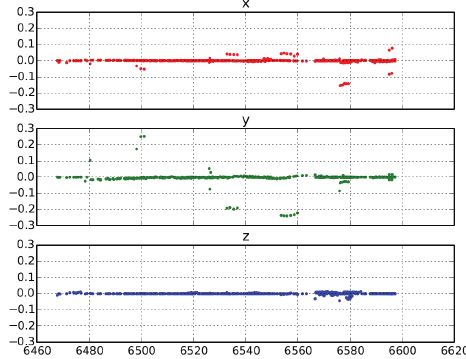
Figure 10. Adjustment result for the anchor points without bounded variations in local neighbourhood (compare to Fig. 9).